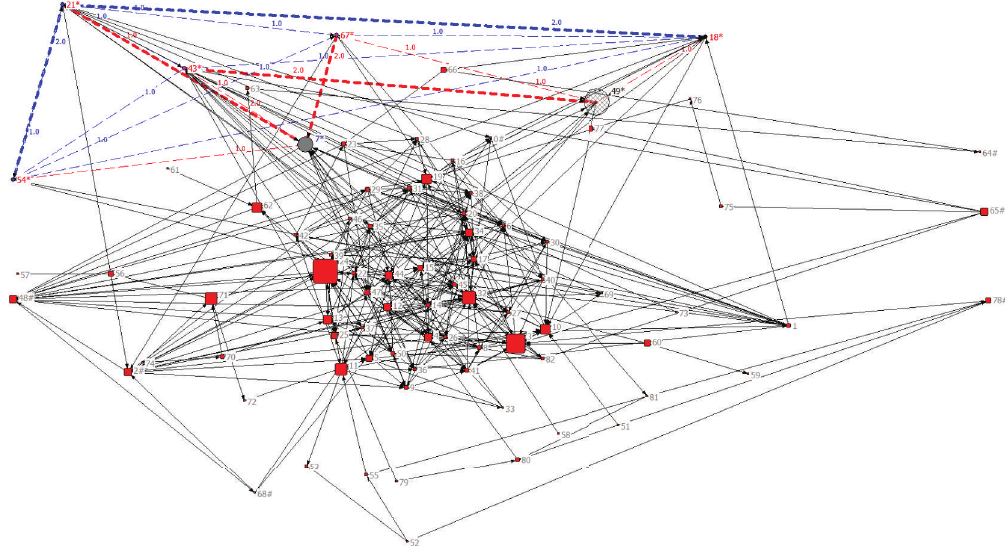
Figure 4: Topological clustering results of complex case.